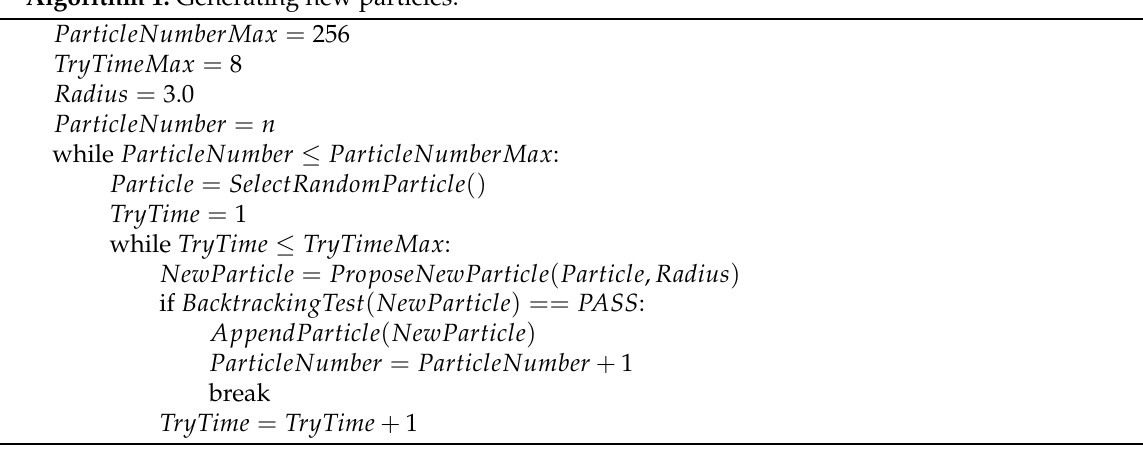
Algorithm 1: Generating new particles.